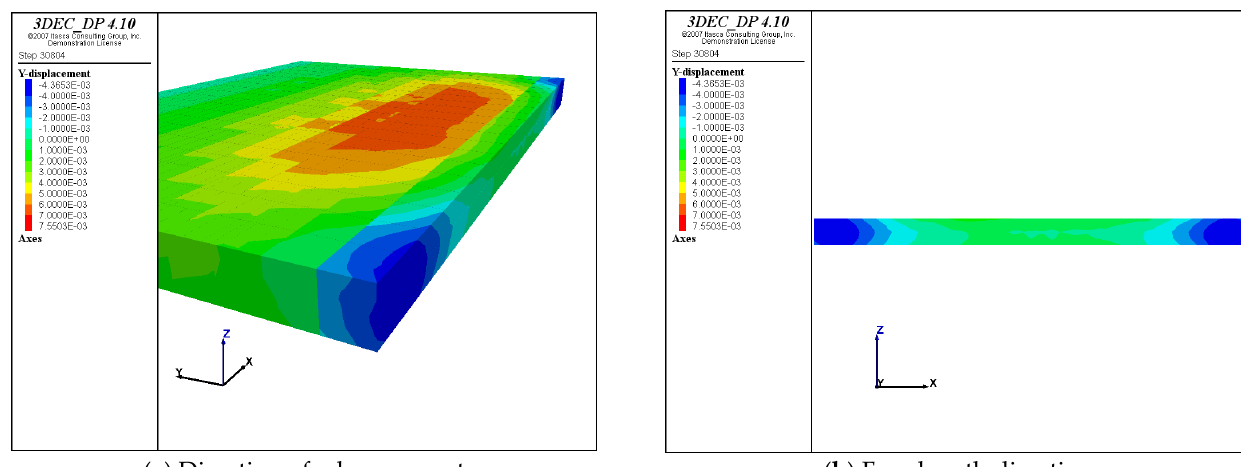
Figure 15. Y-displacement nephogram ( α = 90°).